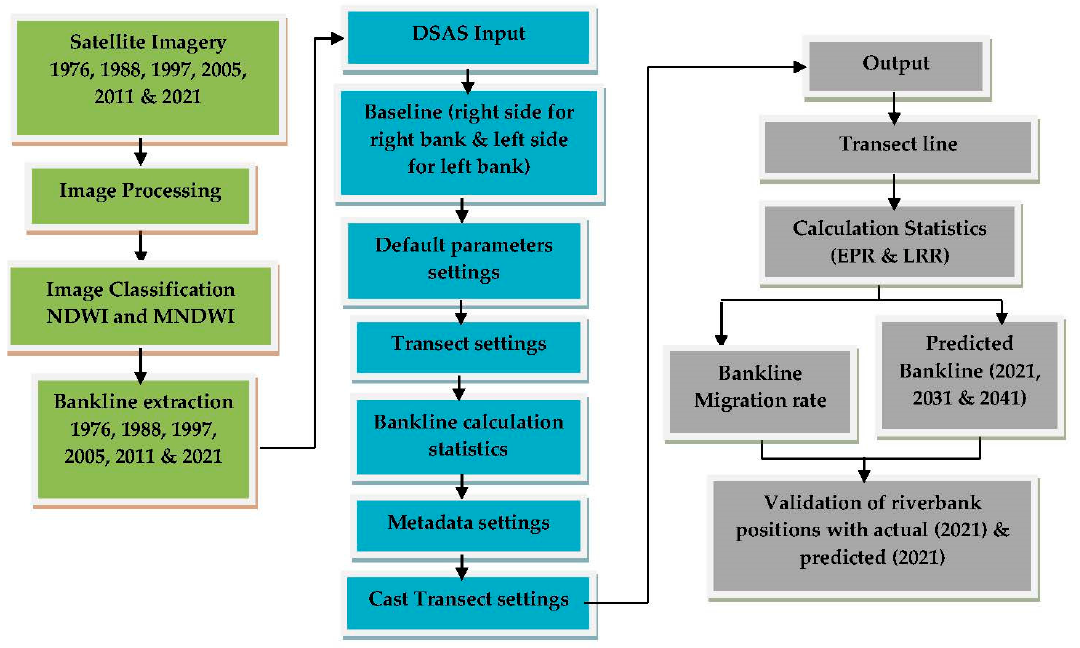
Figure 2. Flowchart of the methodology applied in this study.